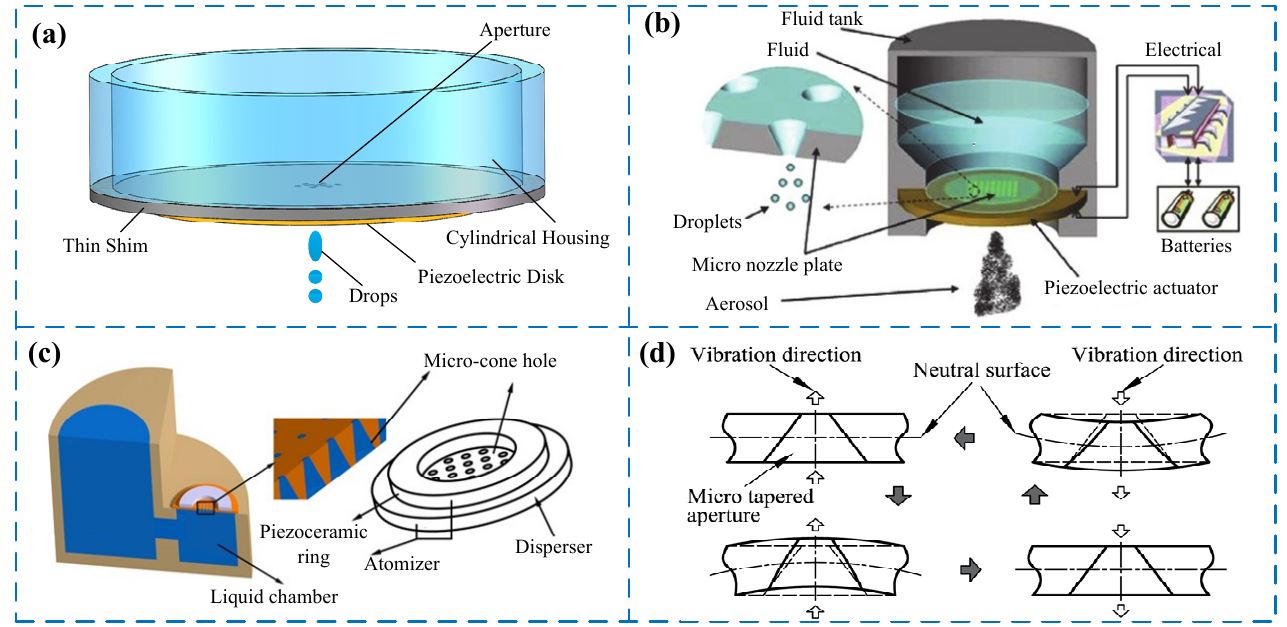
Figure 3. Dynamic mesh atomizer: ( a ) a DMA adapted from Perçin et al. [55–57], ( b ) a new structure DMA by Shen et al. [60], reprinted with permission from Ref. [60]. Copyright 2010 Elsevier, ( c ) a DMA adapted from Cai et al. [61], and ( d ) a diagram of the atomization mechanism adapted from Yan et al.